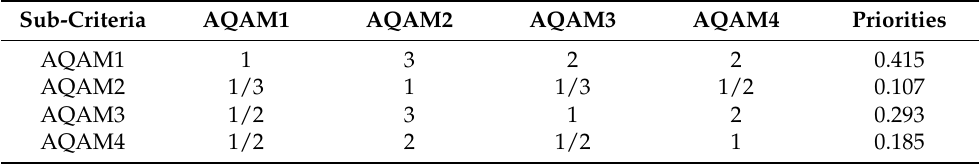
Table 5. Pairwise comparison matrix for the sub-criteria with respect to AQAM. Sub-Criteria